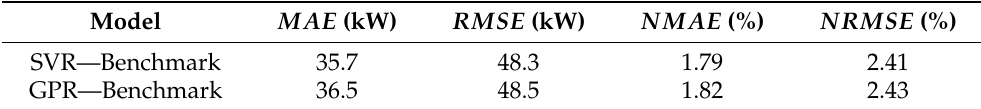
Table 4. Error metrics for the SVR and GPR validation for the benchmark model.